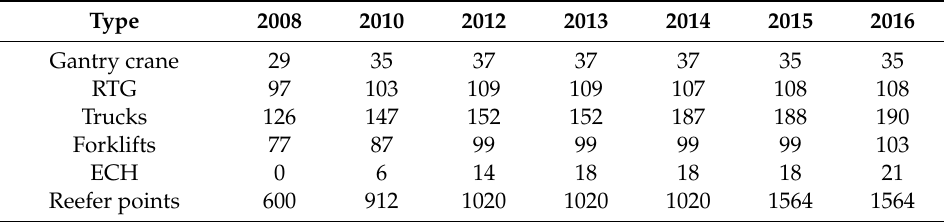
Table 2. Inventory of working machinery and